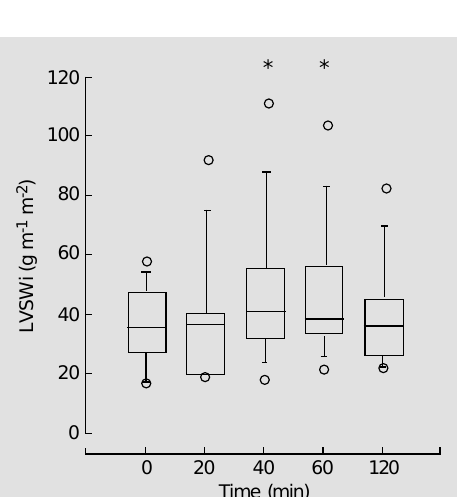
Figure 2 - Time course of left ventricular stroke work index (LVSWi) after intravenous ad- ministration of methylene blue (4 mg/kg) after baseline (time 0) in 10 septic shock patients. Left ventricular stroke work index significantly increased from baseline at 40 and 60 min (*P<0.05 compared to time 0). The box plot lines indicate the median and the 25th and 50th percentiles, and error bars indi- cate the 10th and 90th percen- tiles. The circles indicate the ex- treme